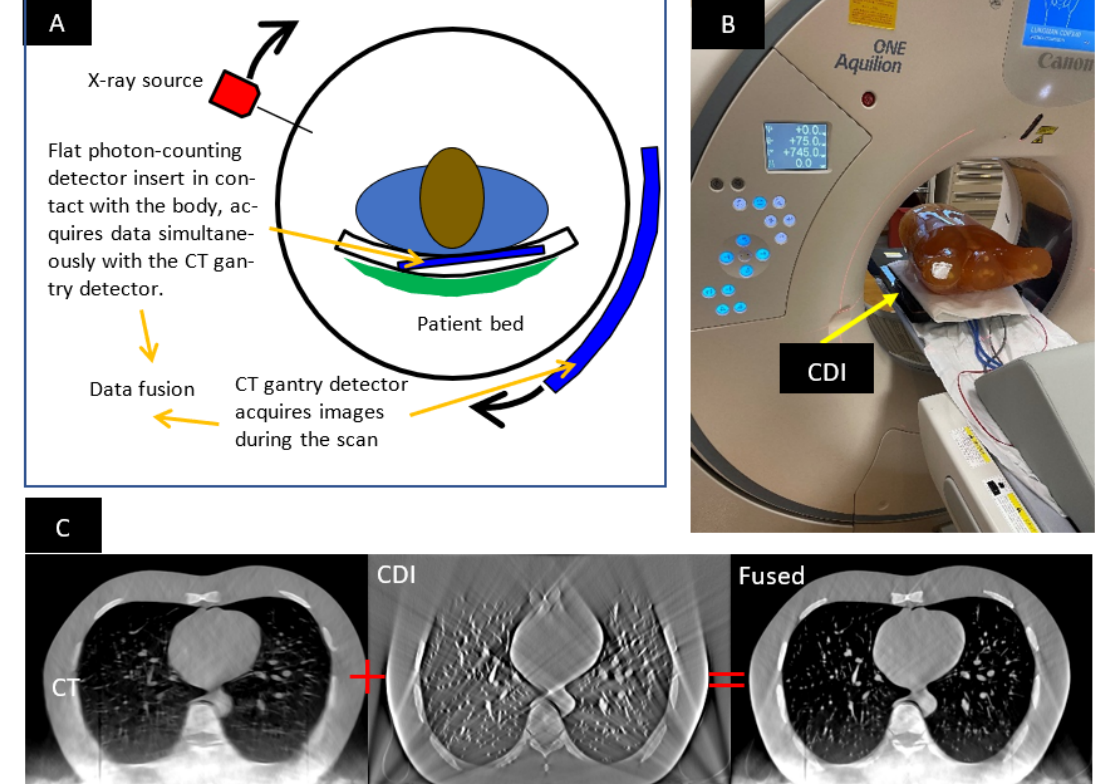
Figure 1. ( A ) Schematic of the hybrid imaging system. ( B ) Experimental hybrid system in a commercial CT scanner with the LUNGMAN chest phantom placed on the contact detector insert. ( C ) The images of the hybrid system are a weighted sum of the images from the CDI and the CT scanner. Each CDI and CT image contains missing information and artifacts from truncated or blocked projection angles. They are complementary to each other, such that the fused image has fewer artifacts and more complete depiction of the anatomical features.